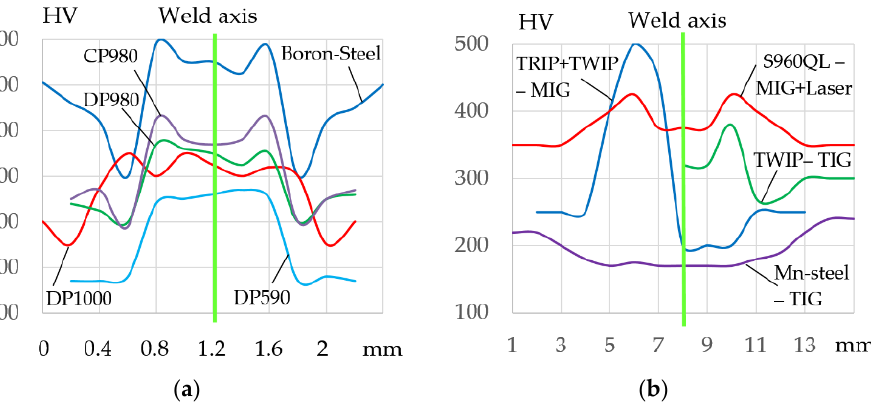
Figure 13. Hardness distribution in the cross-section of the joints of AHSS: ( a ) Laser welding; ( b ) hybrid and arc welding. Data from [104,105,108,112,115,120–123].